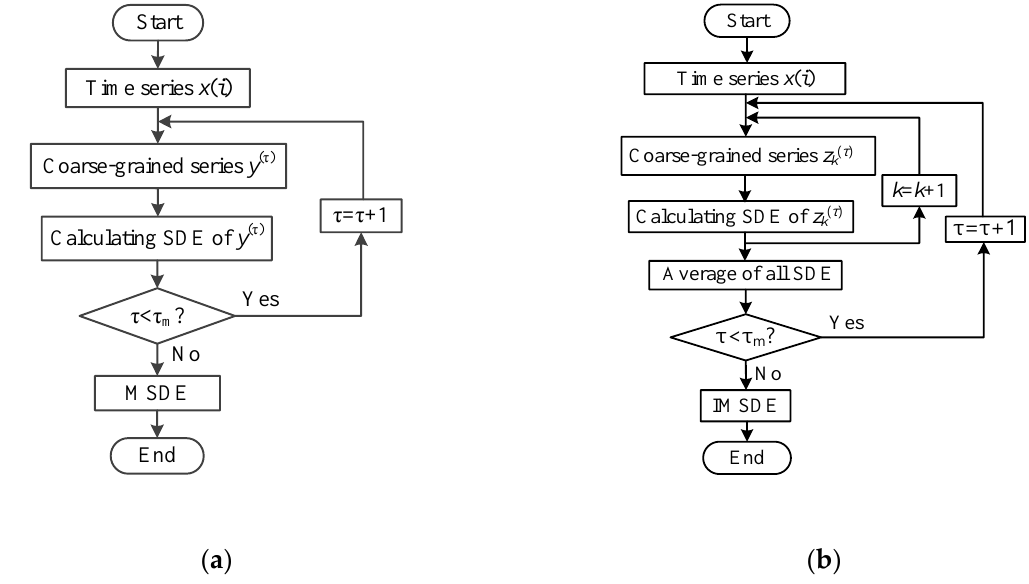
Figure A2. Flowchart comparison between MSDE and IMSDE: ( a ) MSDE and ( b ) IMSDE.